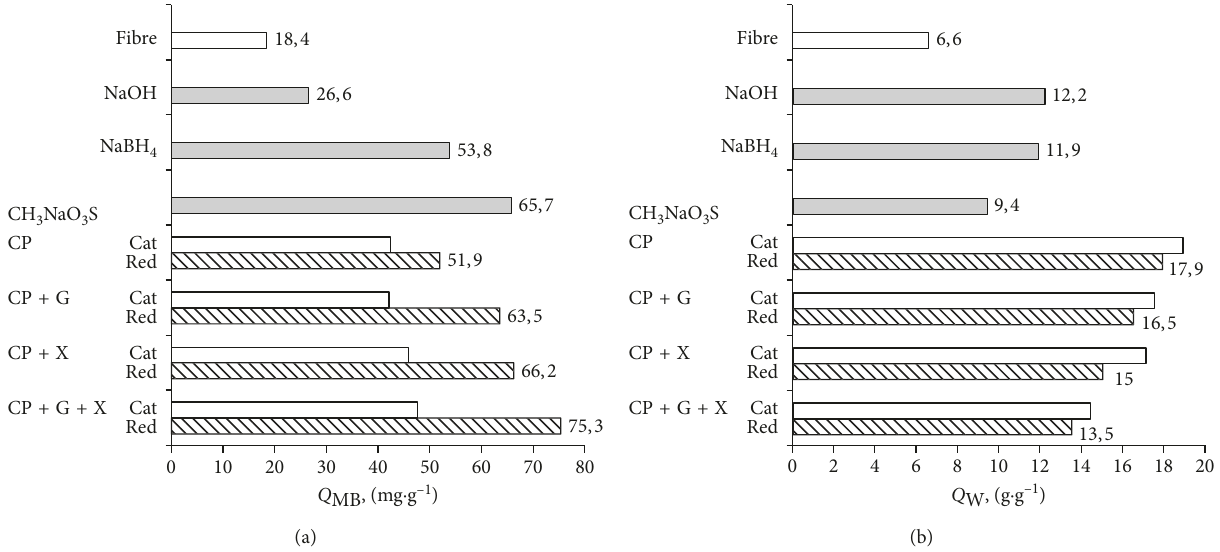
Figure 4: The sorption capacity to methylene blue (a) and water (b) of the initial flax sample and samples after treatments by sodium hydroxide, enzyme preparations, sodium borohydride, and sodium hydroxymethanesulfonate: reductive destruction of